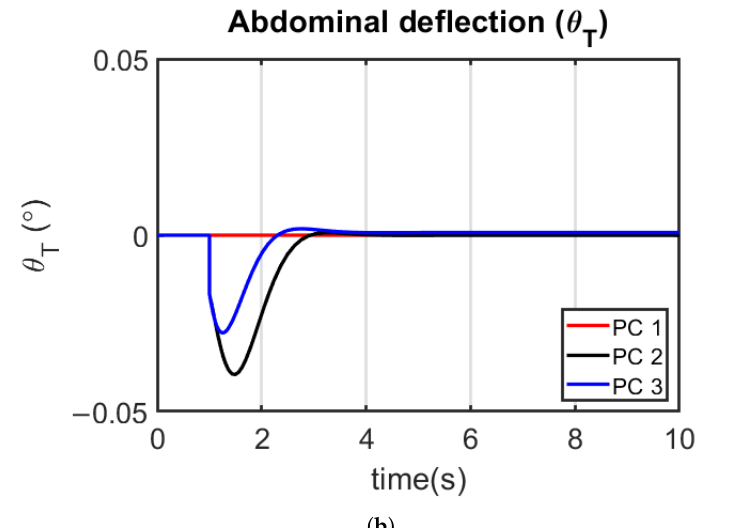
Figure 5. Time histories of the longitudinal control inputs: ( a ) elevator deflection ( δ e ) . ( b ) abdominal pitch angle ( θ T ) . Table 6. Comparison of performance characteristics for the different pitch control (PC)